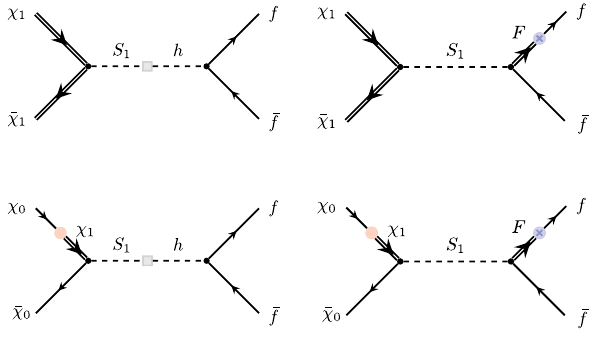
Fig. 6 Leftpanel:massfraction x 1 = m 1 / M KK ofthefirstfermionKK mode in terms of the 5D dimensionless bulk-mass parameter c χ for the case of a left-handed chirality, with Dirichlet and Neumann boundary conditions on the UV and the IR brane, respectively, for two differ- ent values of μ S r . The yellow line corresponds to the case where the fermion bulk masses do not have a dynamical origin, but appear in the